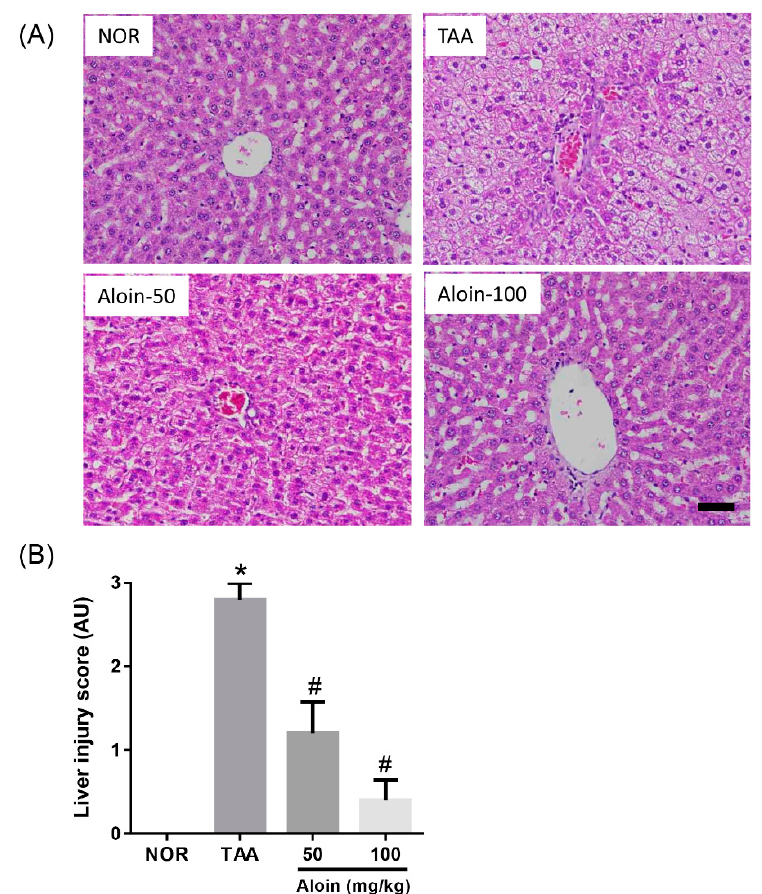
Figure 2. Effect of aloin on liver injury induced by thioacetamide (TAA). ( A ) Histopathological changes in the liver. Liver tissue sections were stained with hematoxylin and eosin. Scale bar = 50 µm. ( B ) Liver injury scores. Values in the bar graphs represent the mean ± SEM, n = 7. * p < 0.05 vs. normal (NOR) control rats, # p < 0.05 vs. TAA-injected rats. AU: arbitrary unit.